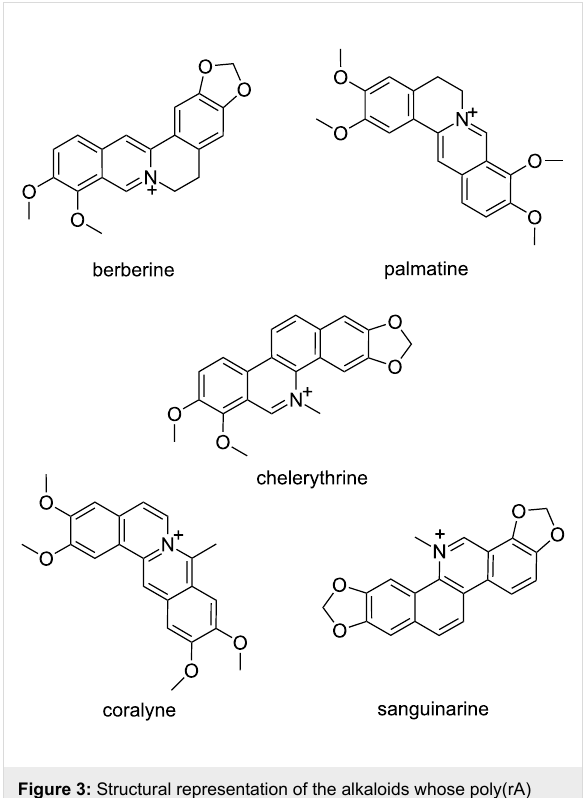
Figure 3: Structural representation of the alkaloids whose poly(rA) binding ability has been investigated.